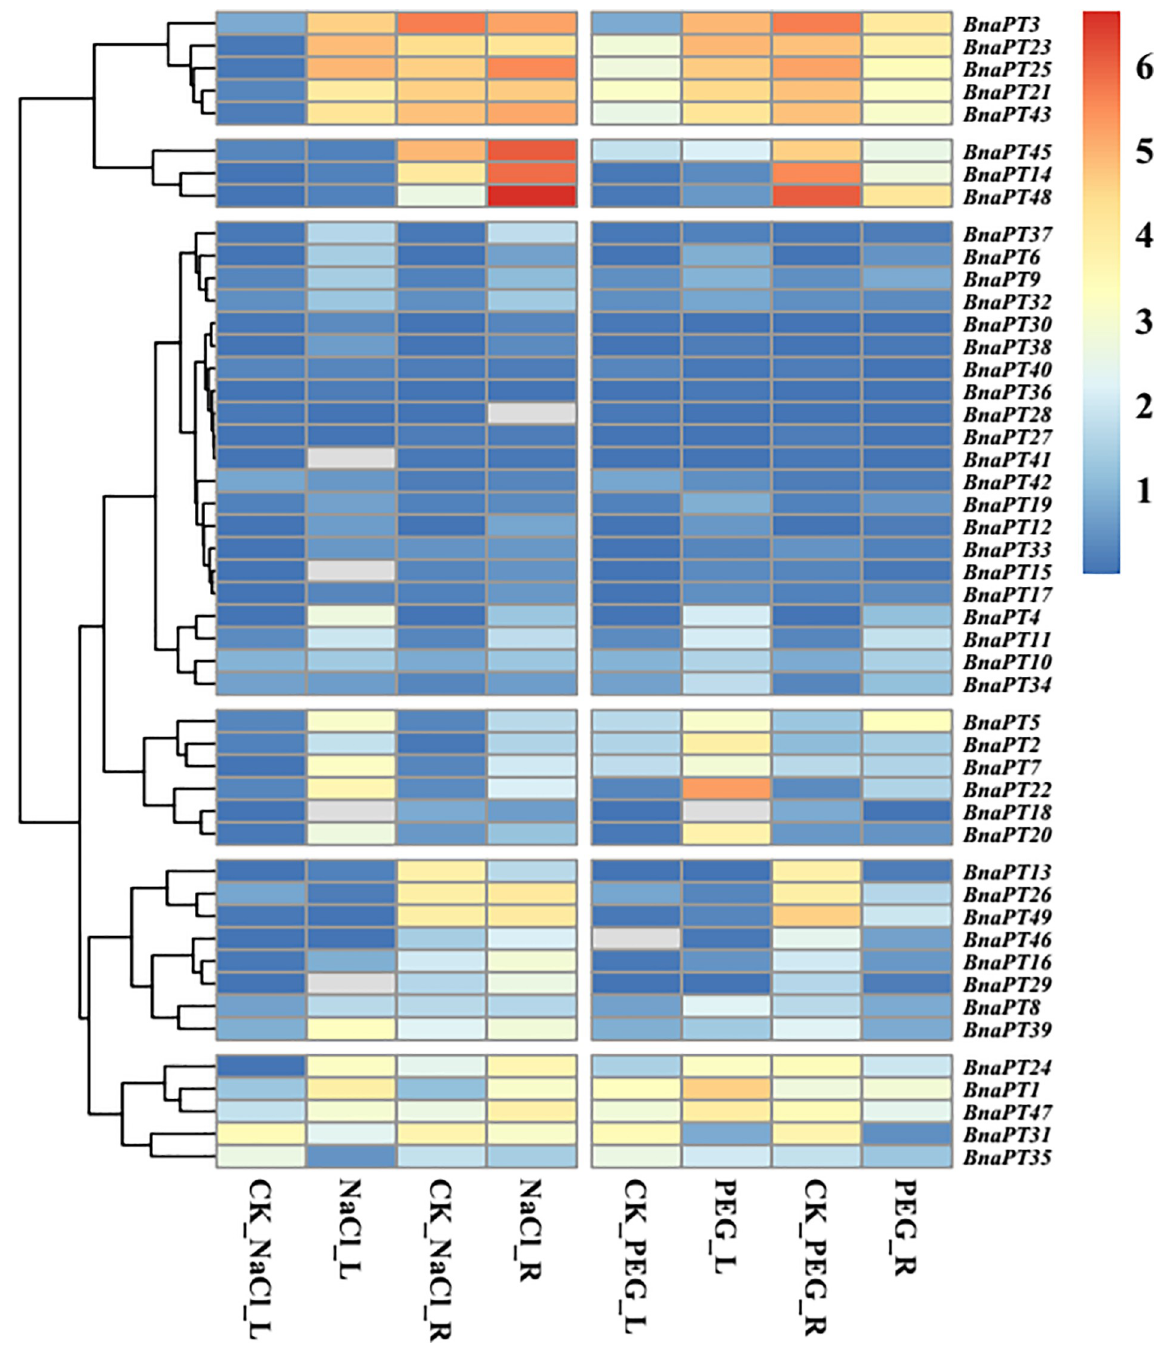
Fig 5. Expression profiles of the PHT1 family genes in the leaves and roots of Brassica napus under salt and drought stresses. For salt stress analysis, 14-d-old seedlings were treated with Hoagland’s solution containing 150mM NaCl for six days. For drought stress analysis, seedlings of 14 days old were treated with Hoagland’s solution containing 20% (W/V) PEG for three days. The full expanded leaf and roots were sampled separately for RNA extraction at harvest. L, leaf. R, roots. CK, full strength Hoagland’s solution. NaCl, salt stress. The color scale is shown on the right side. Gray box indicates data undetected. Heat map of gene expression profiles was generated using pheatmap package in R after data normalization.